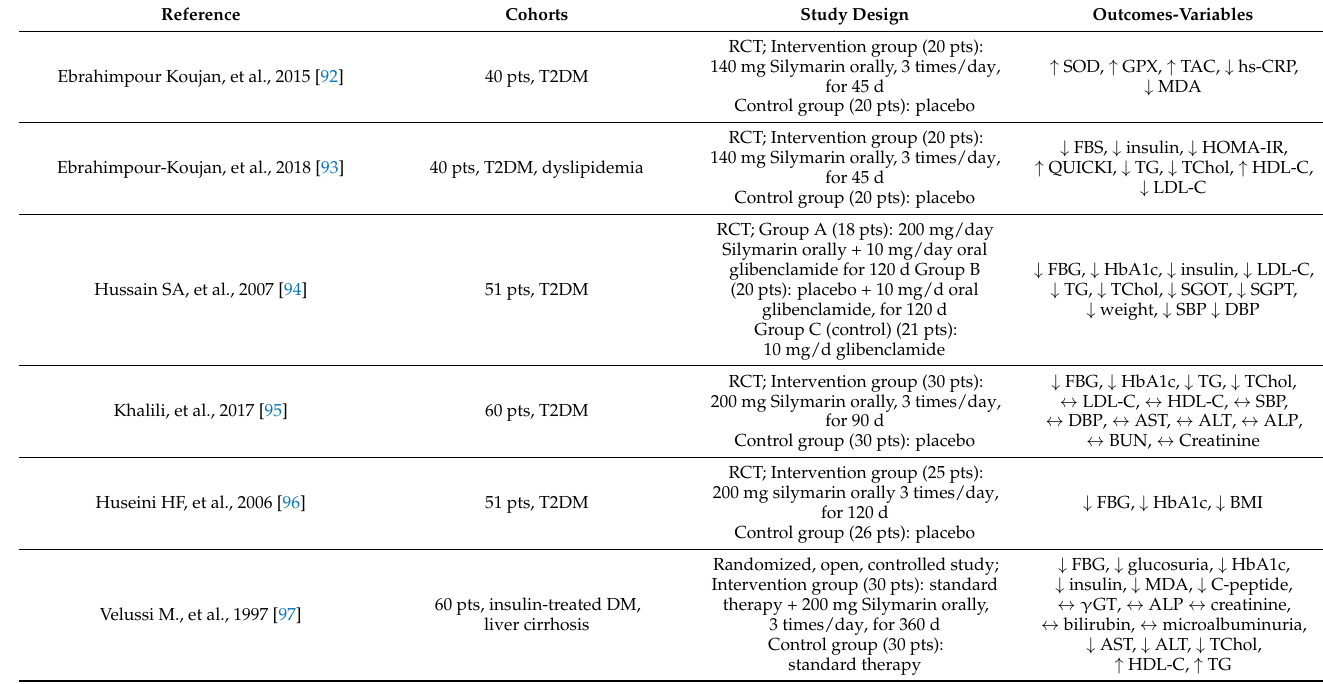
Table 2. Randomized Clinical trials not included in the published meta-analysis studies, investigating the impact of silibinin/silymarin on classical cardiovascular risk